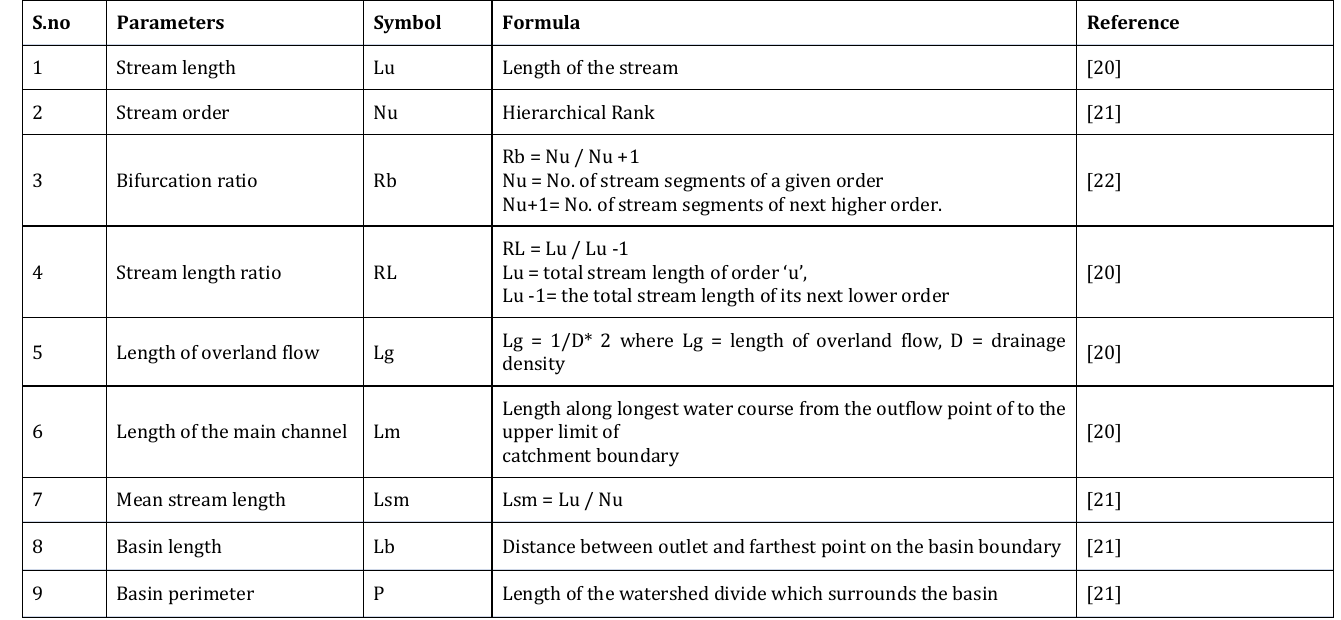
Table 1: Method of calculating linear aspects of the drainage basin